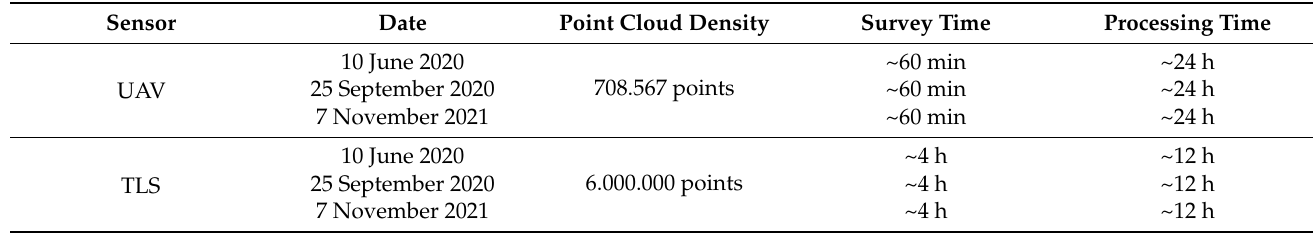
Table 3. Characteristics and computational effort of UAV/TLS point clouds.